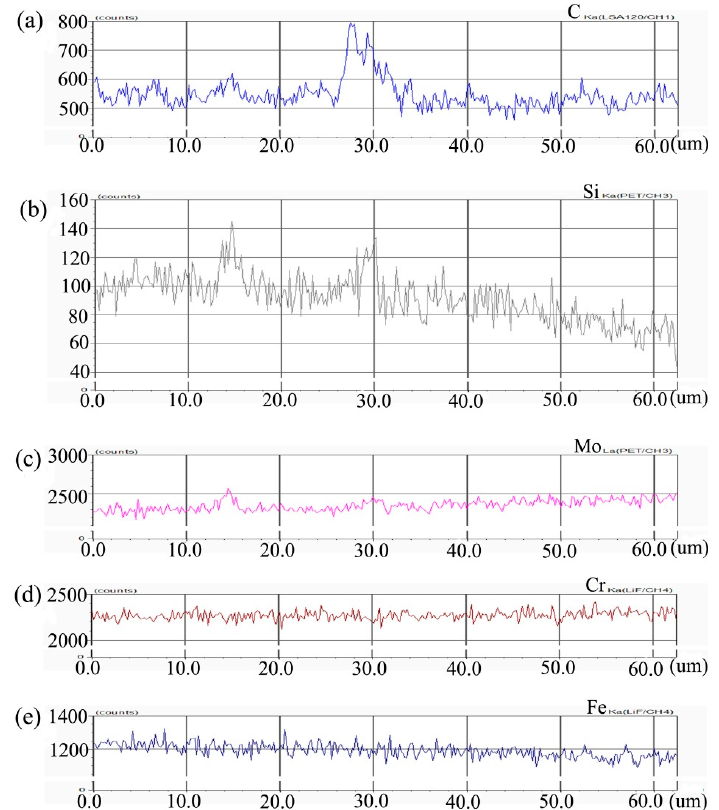
Figure 4. Composition distribution curve of the di ff usion couple sample of 0.45Si and 0.09Si alloy after 1000 ◦ C / 200 h heat treatment: ( a ) C, ( b ) Si, ( c ) Mo, ( d ) Cr, and ( e ) Fe. (The horizontal coordinate of